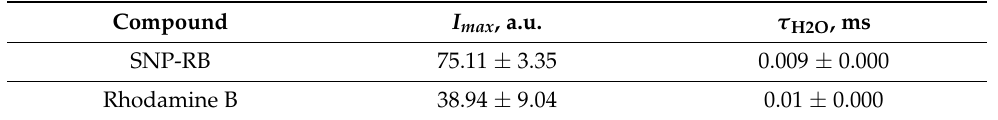
Table 1. The fluorescence maximum intensity ( I max ) and lifetime ( τ ) of SNP-RB and rhodamine B